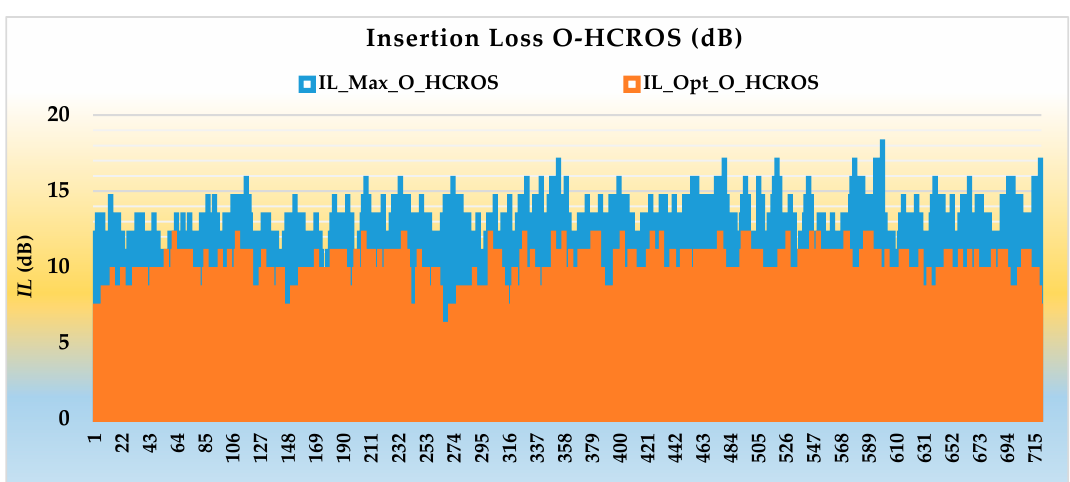
Figure 20. Average insertion loss IL(dB) of un-optimized and optimized HCROS for all I/O links.